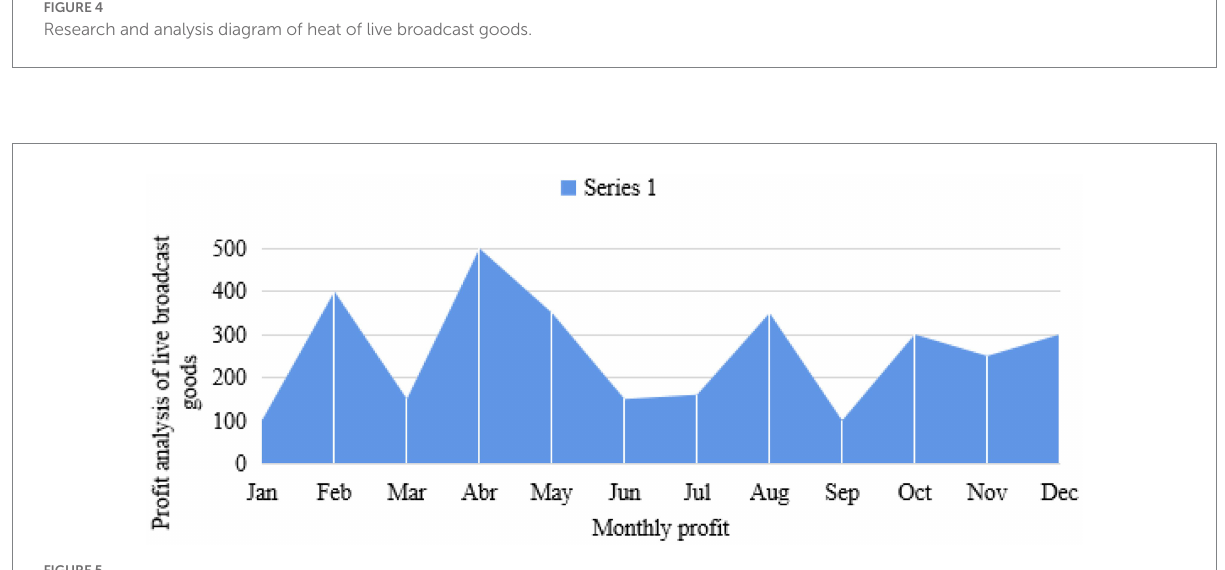
FIGURE 5 Data analysis of live marketing with